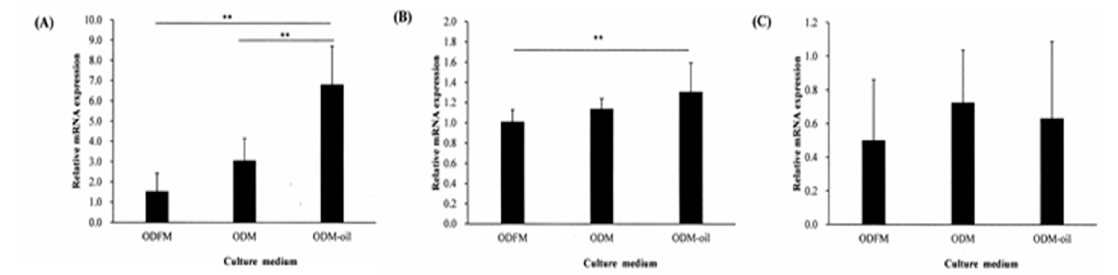
Figure 7. Expressions of odontogenic genes: ( A ) ALP, ( B ) BMP2 and ( C ) DMP-1 following culturing of DPSCs with ODFM, ODM and ODM-oil for 48 h. ** p < 0.01. (Note ODFM: odontogenesis induction-free medium; ODM: odontogenesis induction medium; and ODM-oil: odontogenesis induction medium with S. mukorossi seed oil.).